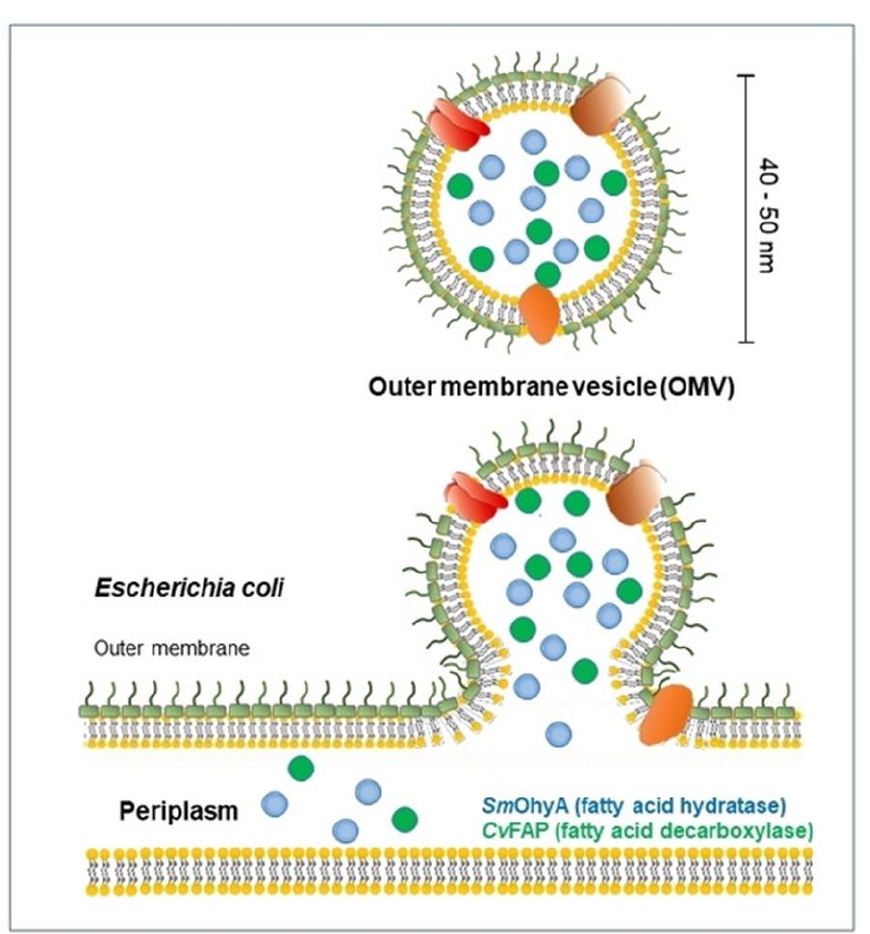
Figure 4. Biogenesis of OMV production in bacteria. Reprinted with permission from Ref. [44]. Copyright: 2021, John Wiley & Sons, Inc.